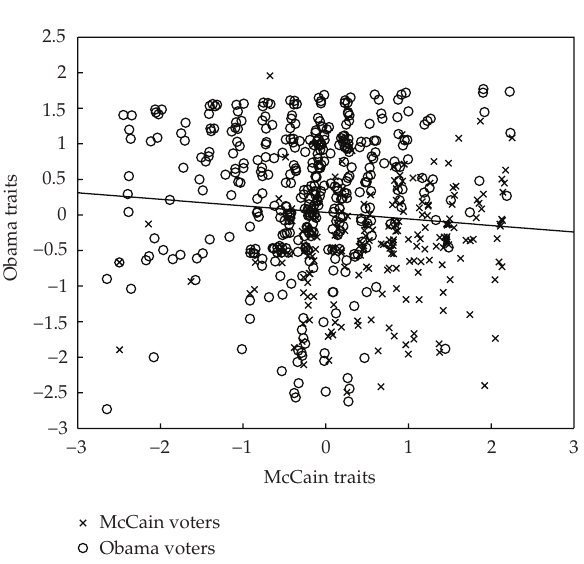
Figure 6: Correlation between Obama and McCain traits, showing vote choice.